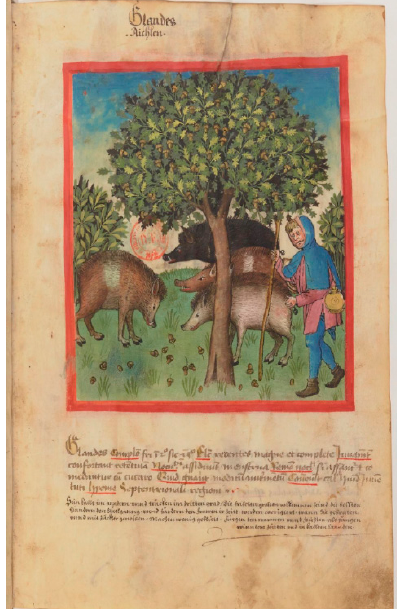
Figure 3. Pig herding scene from the Tacuinum Sanitatis (BnF Ms.Lat.933). Different breeds are present in the same herd. (Source gallica.bnf.fr / Bibliothèque nationale de France)